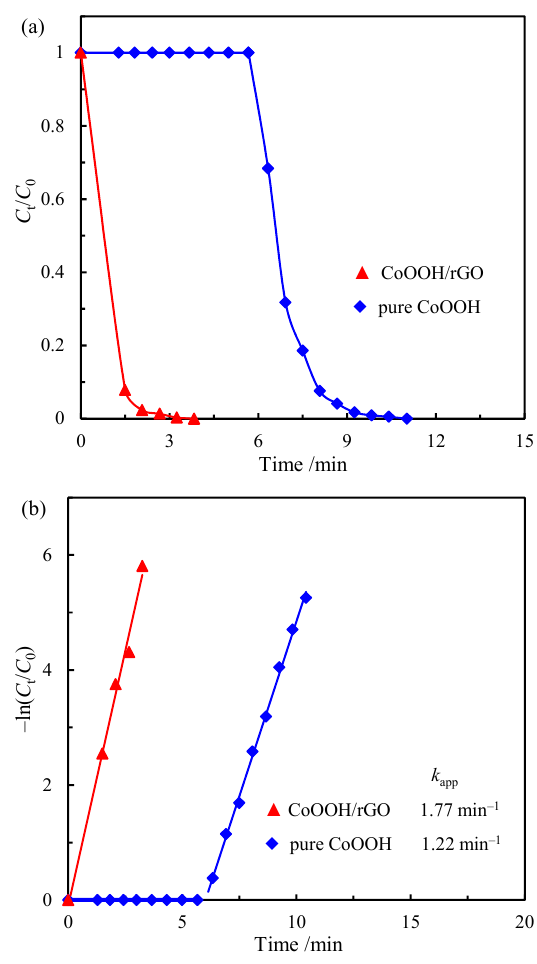
Figure 6. ( a ) C t / C 0 as a function of the reaction time and ( b ) kinetic analysis over pure CoOOH and CoOOH/rGO. Table 2. The induction time of CoOOH/rGO and pure CoOOH in the reduction of p-NP a . Catalyst t 0 /min CoOOH/rGO t 0 < 0.95 pure CoOOH 5.67 < t 0 < 6.33 a Based on the reaction results in Figure 6.